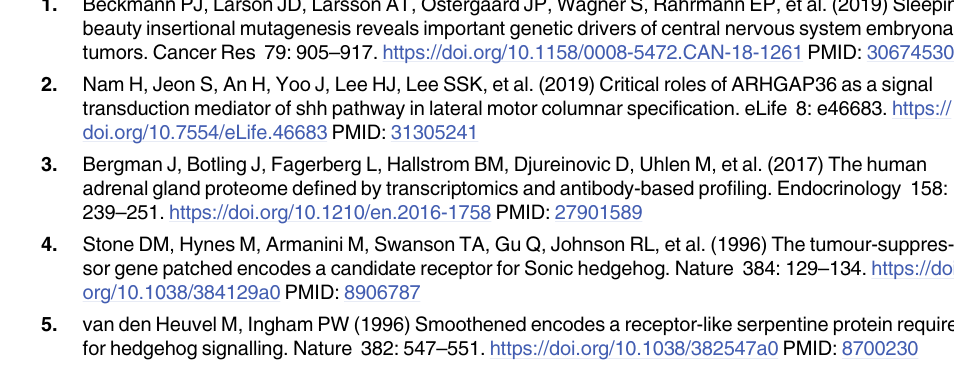
Cell sorting and flow cytometry analyses were conducted at the Stanford Shared FACS Facility. Deep sequencing analyses were performed at the Stanford Functional Genomics Facility. Quantitative proteomics were executed at the Vincent Coates Foundation Mass Spectrometry Laboratory, Stanford University Mass